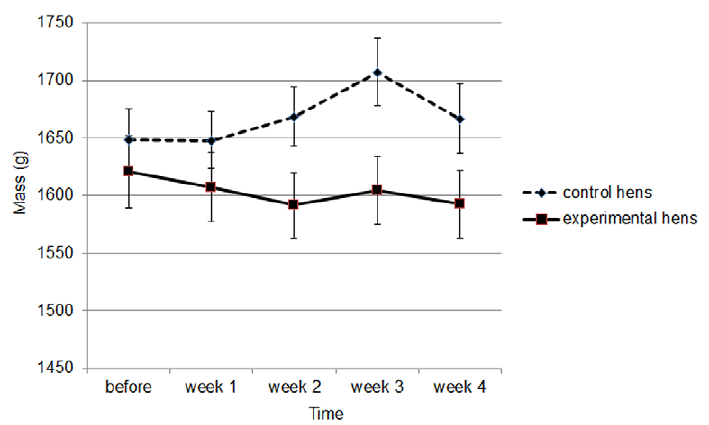
Figure 1. Mean ± SEM mass of control and experimental hens before and during the treatment.